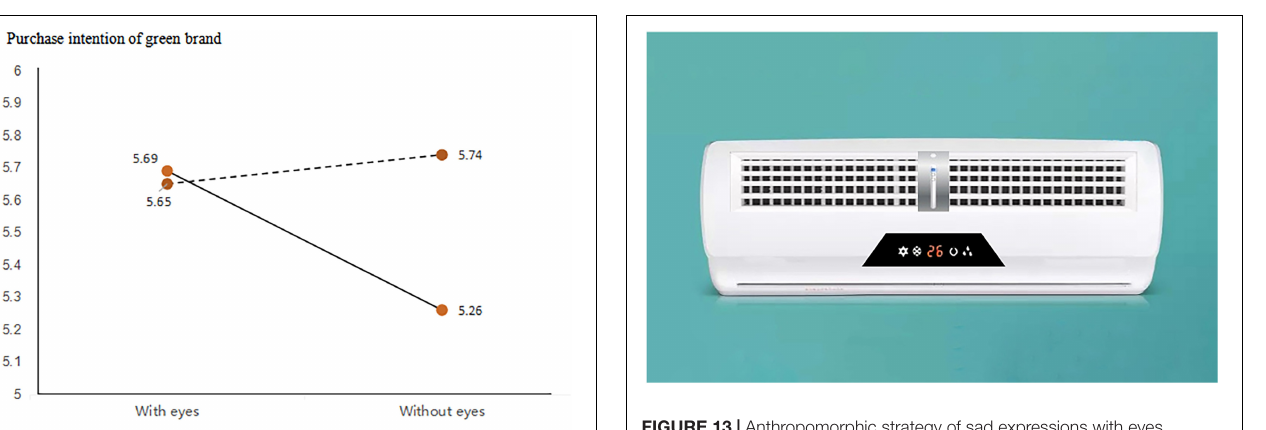
FIGURE 13 | Anthropomorphic strategy of sad expressions with eyes.